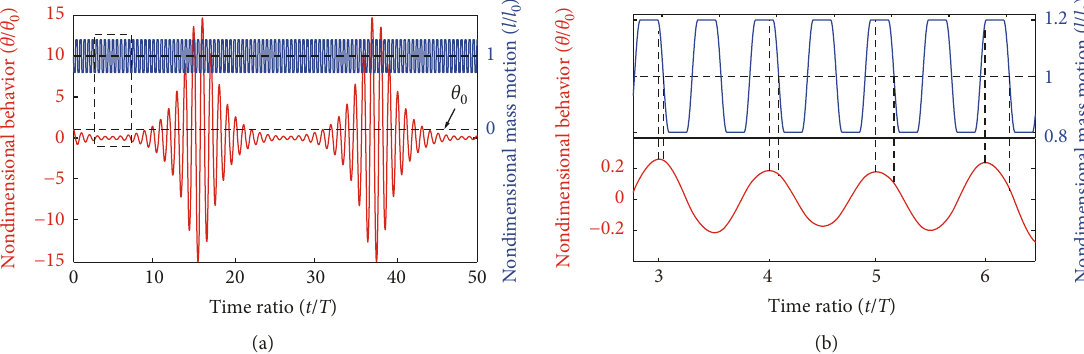
Figure 8: Nonsynchronous motion. (a) θ 0 (cid:30) 0.1 rad, the effects of the motion distance 4/15, the effect of the initial amplitude θ 0 on the exact damping ratio ζ e damping ratio ζ e ; (b) ∆ L / L (cid:30)